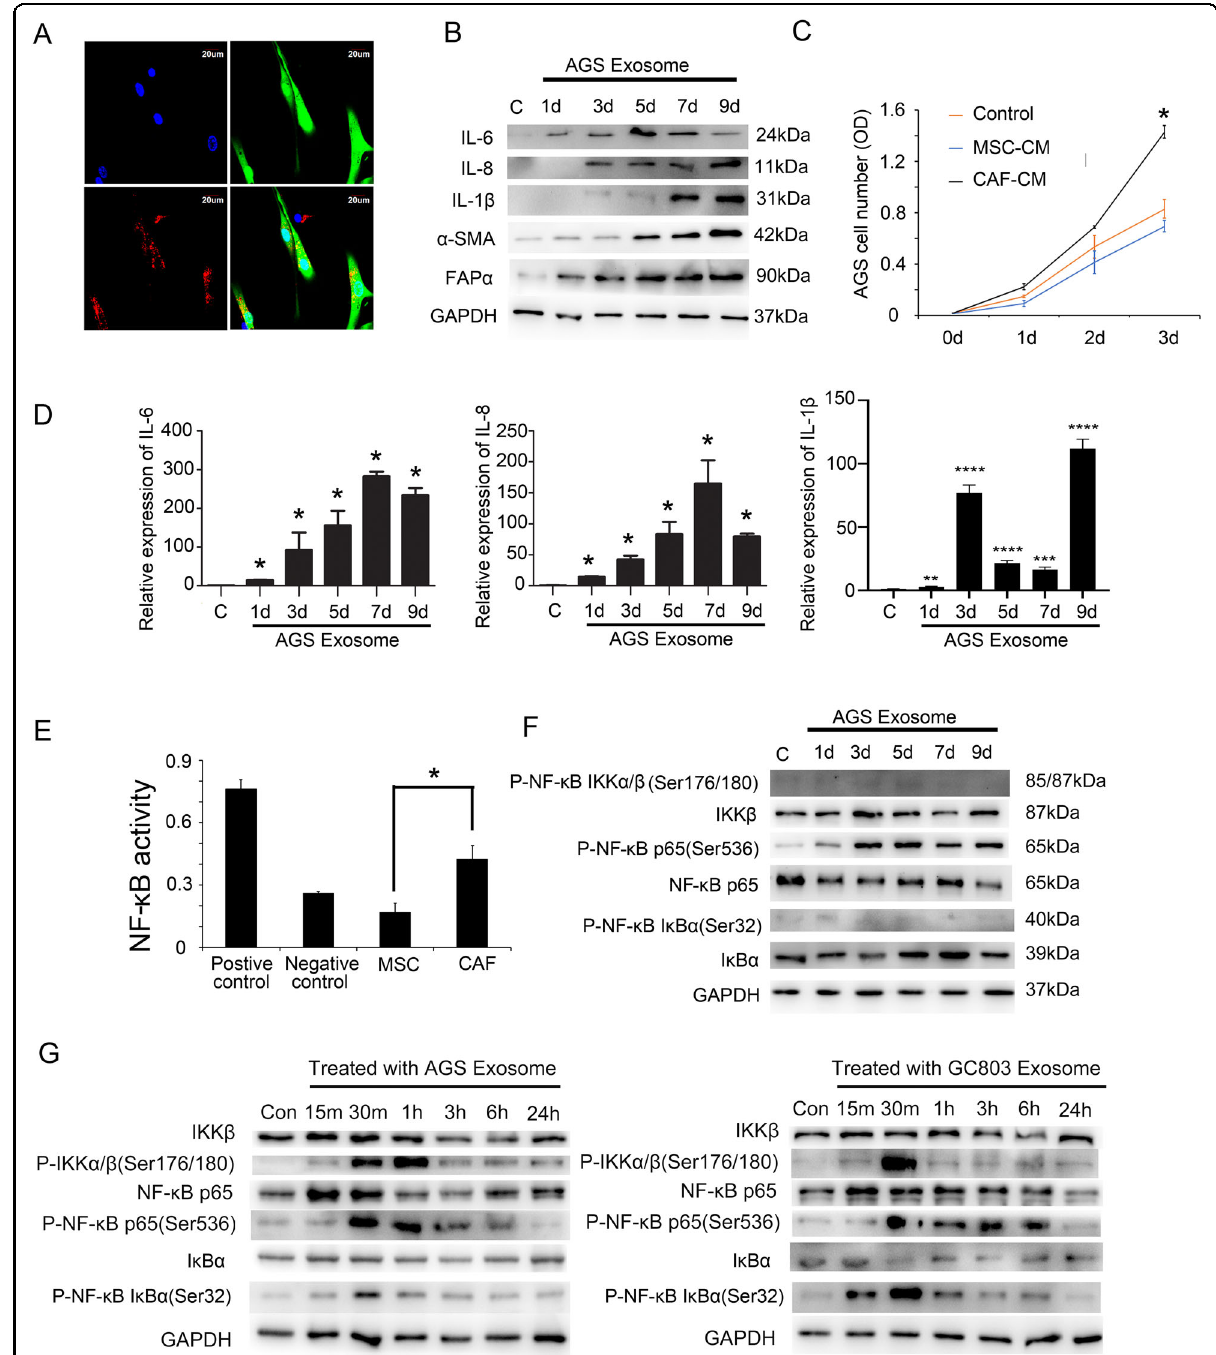
Fig. 1 Gastric cancer exosomes induced differentiation of MSCs into CAFs. A Confocal microscopy detected that MSCs (eGFP-Green) could take up gastric cancer exosomes (Dil-Exosome) into the cytoplasm; B western blotting analysis showed that the expression of CAF-speci fi c biomarkers and in fl ammatory factors was upregulated after treatment with AGS exosomes. C CAF-conditioned medium promoted AGS proliferation, which was signi fi cantly different from the AGS control group. Control group: AGS culture medium, MSC-CM: MSC conditioned medium, CAF-CM: CAF conditioned medium. * P < 0.05. D Quantitative PCR analysis detected that the expression of in fl ammatory factors and chemokine in CAFs differentiated from MSCs after treatment with AGS exosomes. * P < 0.05, ** P < 0.01, *** P < 0.001, **** P < 0.0001. E NF- κ B transcriptional activity increased when MSCs were induced to differentiate into CAFs by AGS exosomes. * P < 0.05. F Western blotting analysis detected the NF- κ B signaling pathway protein expression in CAFs differentiated from MSCs after treatment with AGS exosomes on days 1, 3, 5, 7, and 9. G Western blotting analysis detected the NF- κ B signaling pathway protein expression in CAFs differentiated from MSCs after treatment with AGS exosomes at 15min, 30min, 1 h, 3 h, 6 h, and